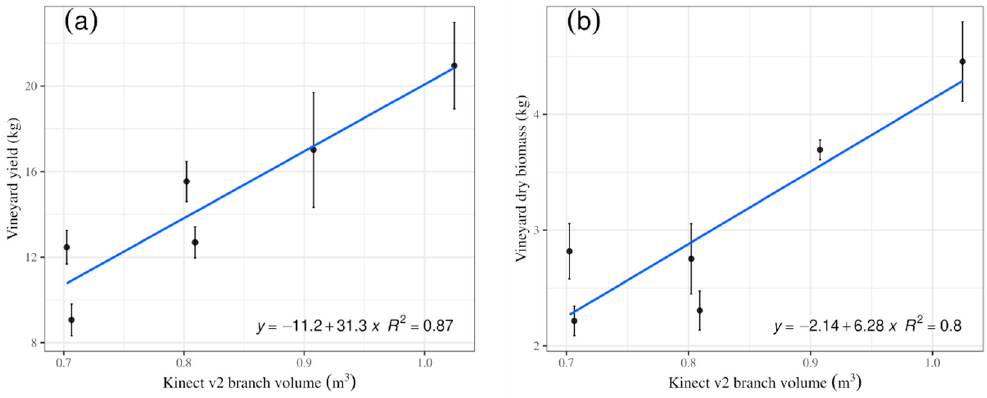
Figure 6. ( a ) Kinect volume versus vineyard dry biomass (average per treatment). ( b ) Kinect volume versus value for grape yield (average per treatment). Table 1. Regression slope coefficients, standard error, P-value of the F-tests and corresponding 95% confidence intervals (95% CI) of the estimated slopes, indicating the meaningful correlations between Kinect v2 calculated volume and the measured response variables vineyard yield and dry biomass.